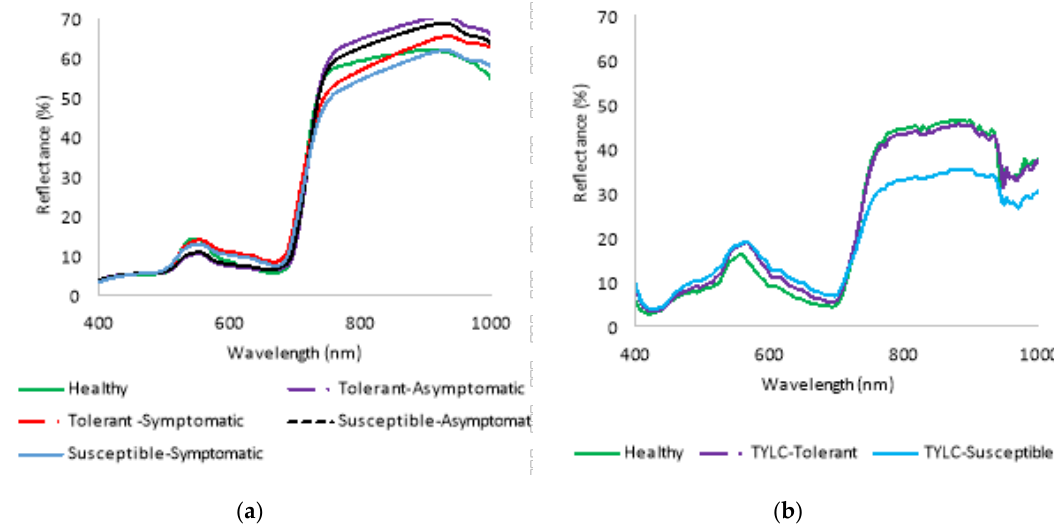
Figure 3. The spectral reflectance signatures of healthy, TYLC-infected (tolerant and susceptible varieties) tomato plants: ( a ) in laboratory conditions and ( b ) field conditions.